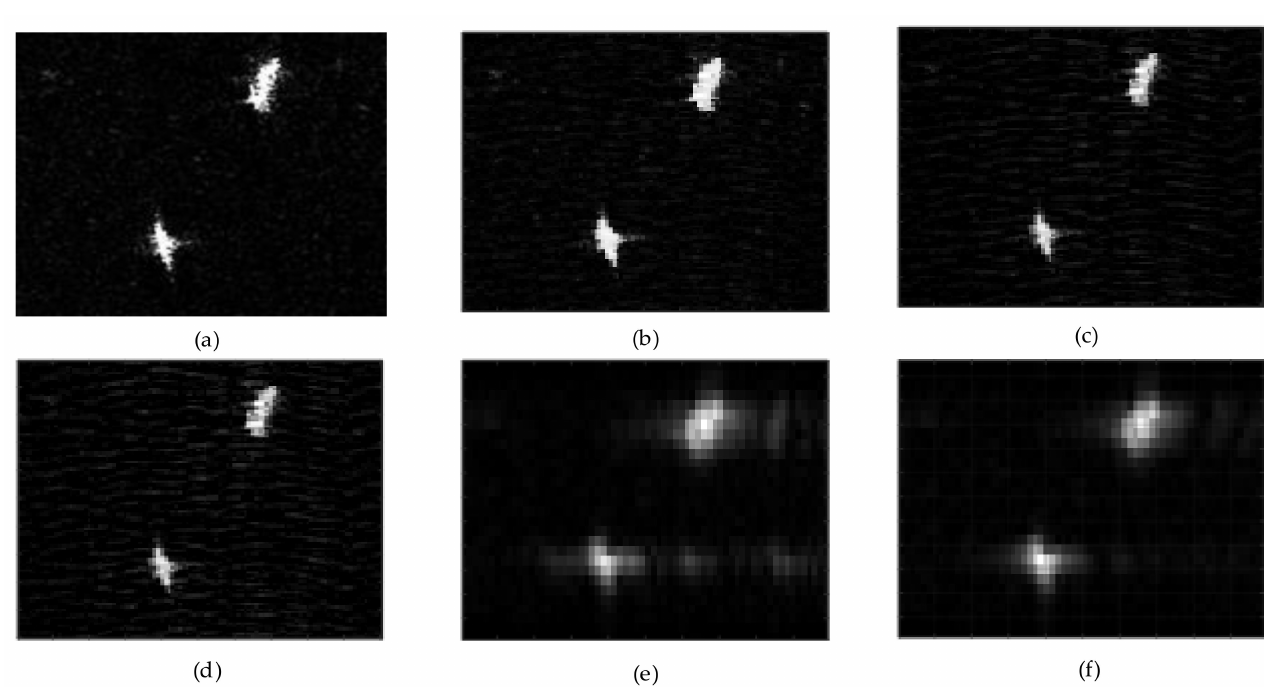
Figure 6. Ship targets on the sea imaging results. ( a ) is original ship target, ( b ) is our proposed method with L = 3, ( c ) is our proposed method with L = 8, ( d ) is our proposed method with L = 11, ( e ) is ISTA method and ( f ) is Fast ISTA method.